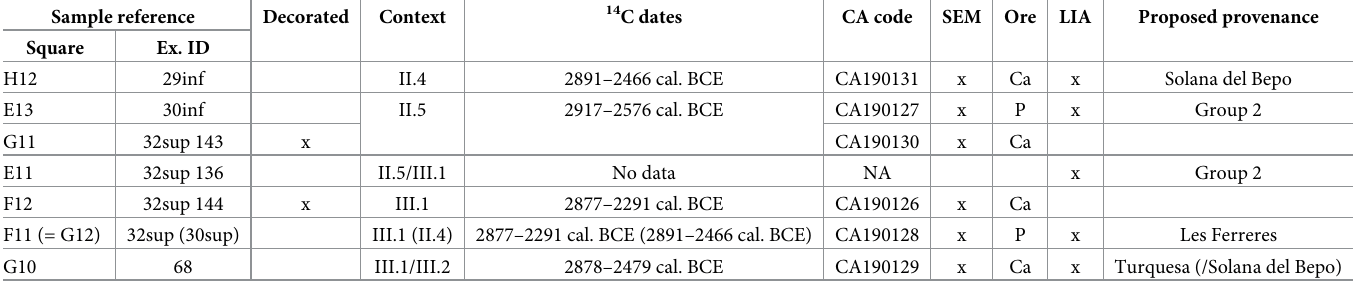
Table 1. Samples analysed, their stratigraphic context, 14 C calibrated dates, analyses conducted and summary of results. Samples are arranged following stratigraphic order, from the most superficial level at the top and the deepest one at the bottom. Sample